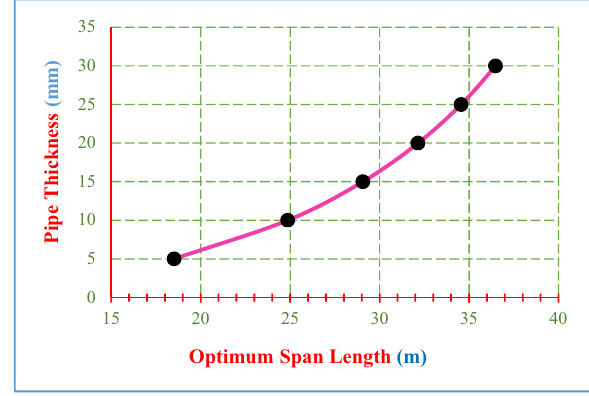
Figure 14: Steel stress vs safe span length.